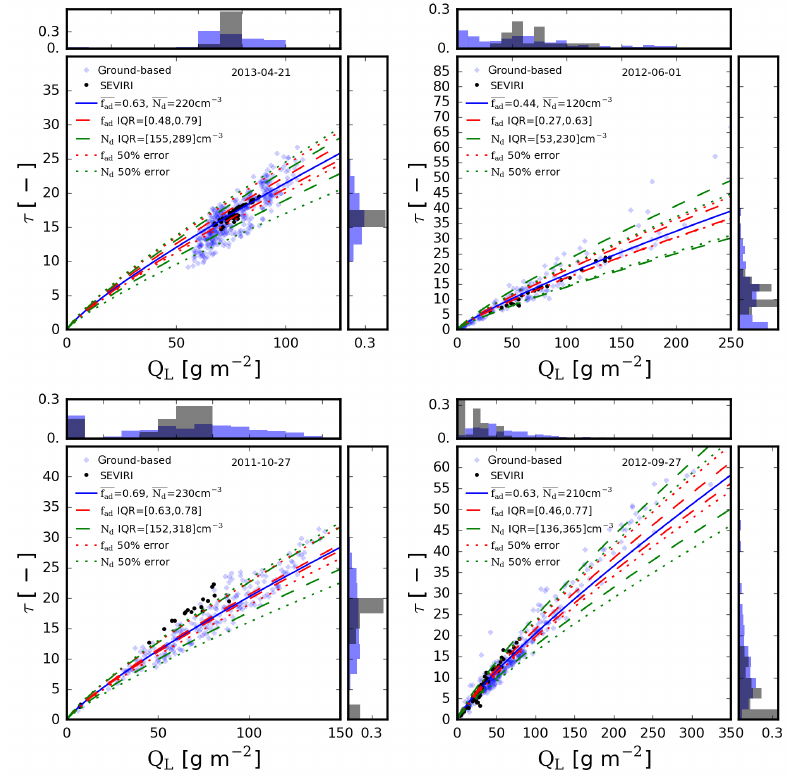
Figure 5. Relationship between Q L and τ for the four case days (Table 2). Blue crosses represent the LACROS observations for the case day, black dots the SEVIRI observations. The solid blue line represents the relationship between τ and Q L for the median f ad and N d of the LACROS observations. Uncertainty estimates of τ as a function of Q L is given in terms of temporal variability using the IQR of the time series (dashed), and as 50% relative uncertainty in N d and f ad (dotted). Furthermore the histograms of ground-based and SEVIRI observations are shown on each axis in the same colours as stated